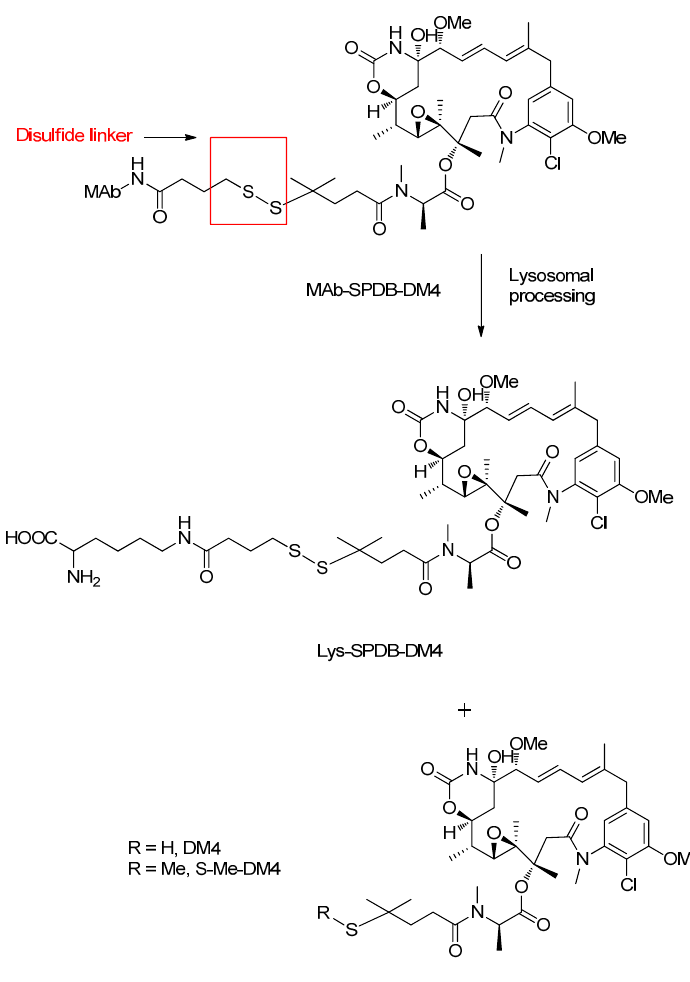
Figure 9. The structural formula of huC242-SPDB-DM4 and the supposed cleavage mechanism after internalization into the lysosome. Adapted from reference [49,67].